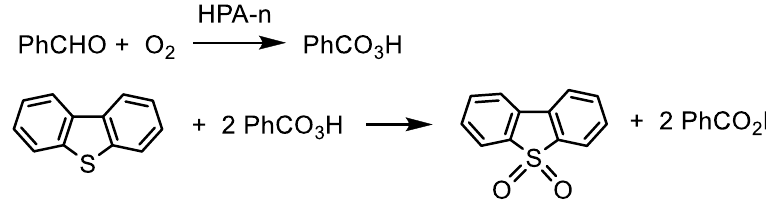
Scheme 1. Aerobic oxidation of DBT in the presence of PhCHO as a sacrificial reductant. The co-oxidation of PhCHO and DBT by O 2 catalyzed by HPA-1 can be represented